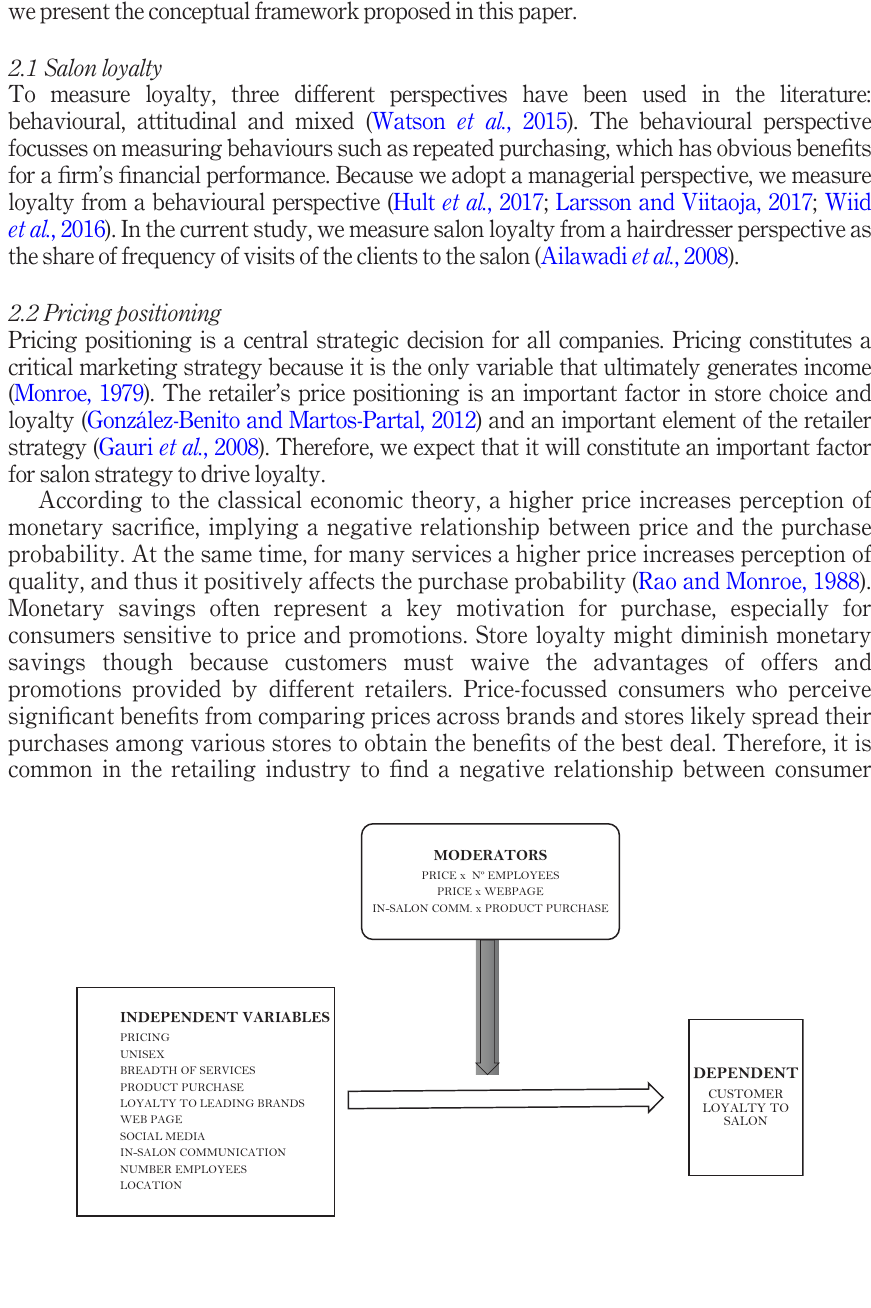
Figure 1. Conceptual framework